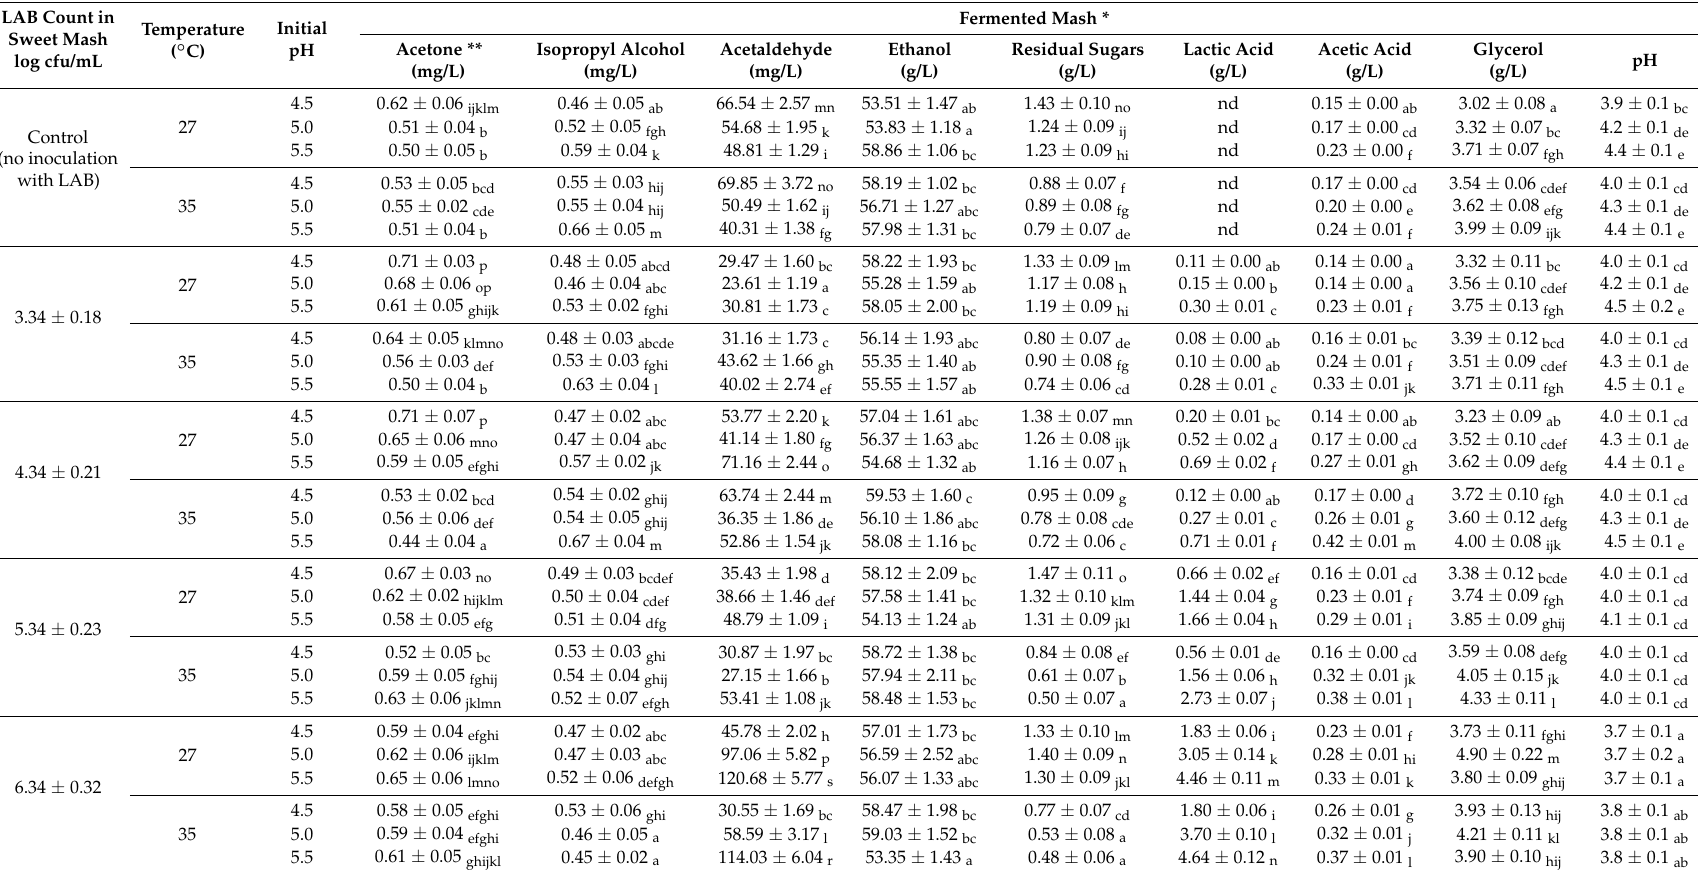
Table 2. Results of chemical analysis of fermented mashes (data presented as Mean ±